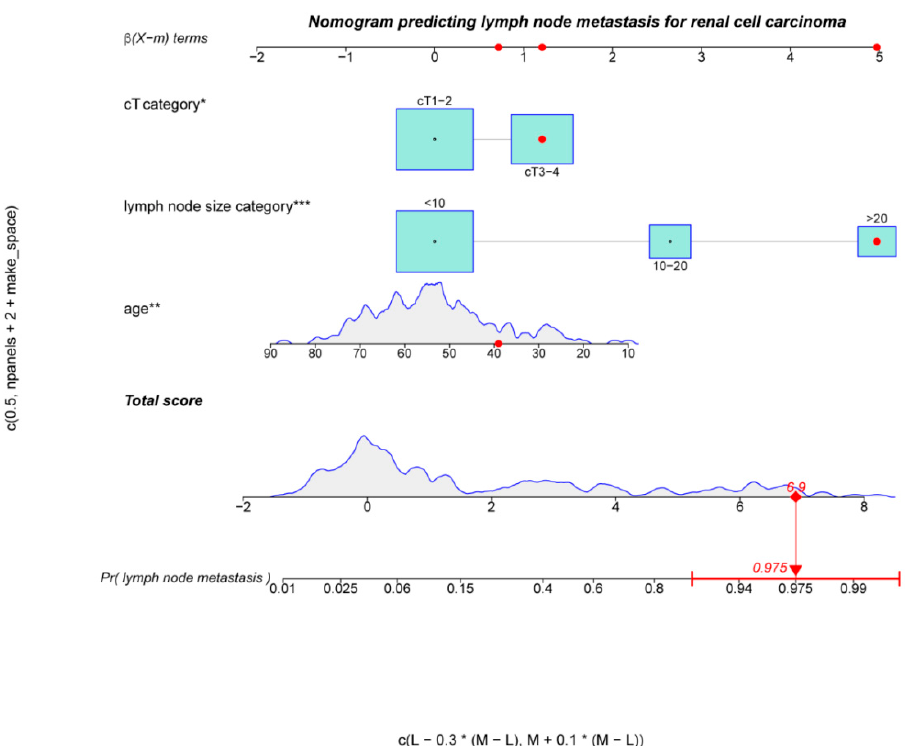
Figure 2. Nomogram of patients for predicting the risk of lymph node metastasis. Total score was 6.9, and the corresponding probability of lymph node metastasis was 97.5%. The asterisks represented the statistical p value (* p < 0.05; ** p < 0.01; *** p < 0.001).